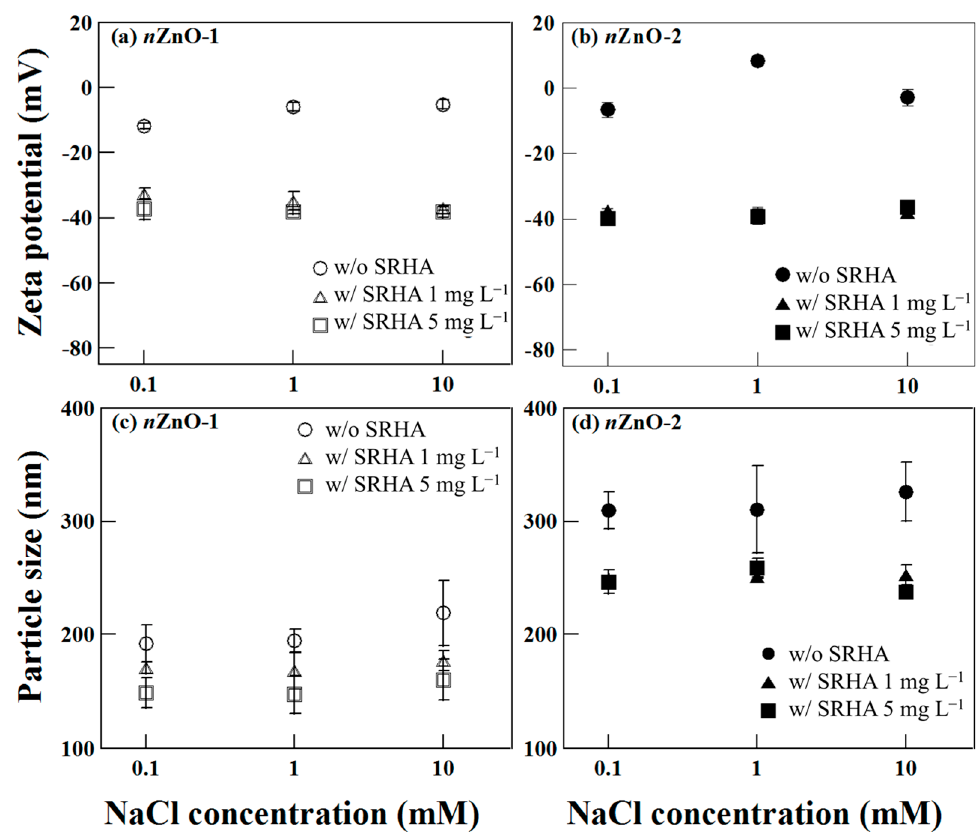
Figure 2. Zeta potentials ( a , b ) and DLS particle sizes ( c , d ) of n ZnO in the absence (w/o SHRA) and presence (w/SRHA) of SRHA at different ionic strengths in both NaCl solutions at pH 9 (adjusted with 0.1 M NaOH). Table 1. Physical properties of n ZnO prepared by two different synthesis methods.